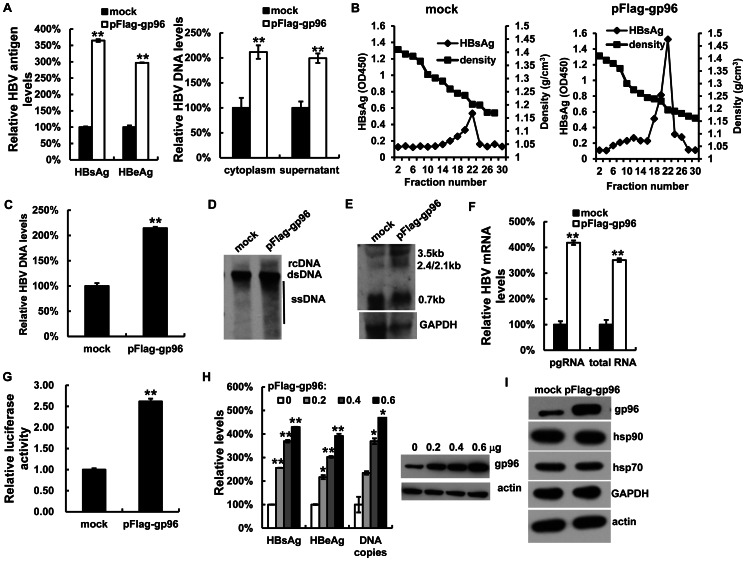
Over-expression of gp96 increases HBV production in vitro.Chang cells were co-transfected with pFlag-gp96 or pEGFP-C1 (mock) and pHBV. (A) The levels of HBsAg and HBeAg in the culture supernatant were measured by ELISA (left panel), and the HBV DNA levels in the culture supernatant and cytoplasm were quantified by real-time PCR (right panel). (B, C) The culture supernatants were subjected to isopycnic centrifugation in a gradient of 20 to 50% (wt/vol) cesium chloride. Fractions of 400 µl were collected, dialyzed and assayed for the HBsAg by ELISA (B). The fractions corresponding to the virion particles (density: 1.22–1.24 g/cm3) were pooled for DNA extraction, and analyzed by real-time PCR (C). (D) The cytoplasmic HBV DNA was detected by Southern blotting. rcDNA, relaxed circular; dsDNA, double-stranded; ssDNA, single-stranded HBV DNA. (E and F) HBV pgRNA and total RNA levels were determined by northern blotting (E) and real-time PCR (F). (G) Chang cells were co-transfected with pHBV-luc and pFlag-gp96. At 48 h post-transfection, the relative luciferase activity was determined. (H) Chang cells were co-transfected with pHBV along with increasing amounts of pFlag-gp96. 48 h post-transfection, the levels of HBsAg, HBeAg, and HBV DNA copies in the supernatant were analyzed. (I) The protein levels of gp96, hsp90, hsp70, GAPDH and actin were determined by western blotting. Data are presented as the means ± SD from three independent experiments. *P<0.05 and **P<0.01 compared to mock.